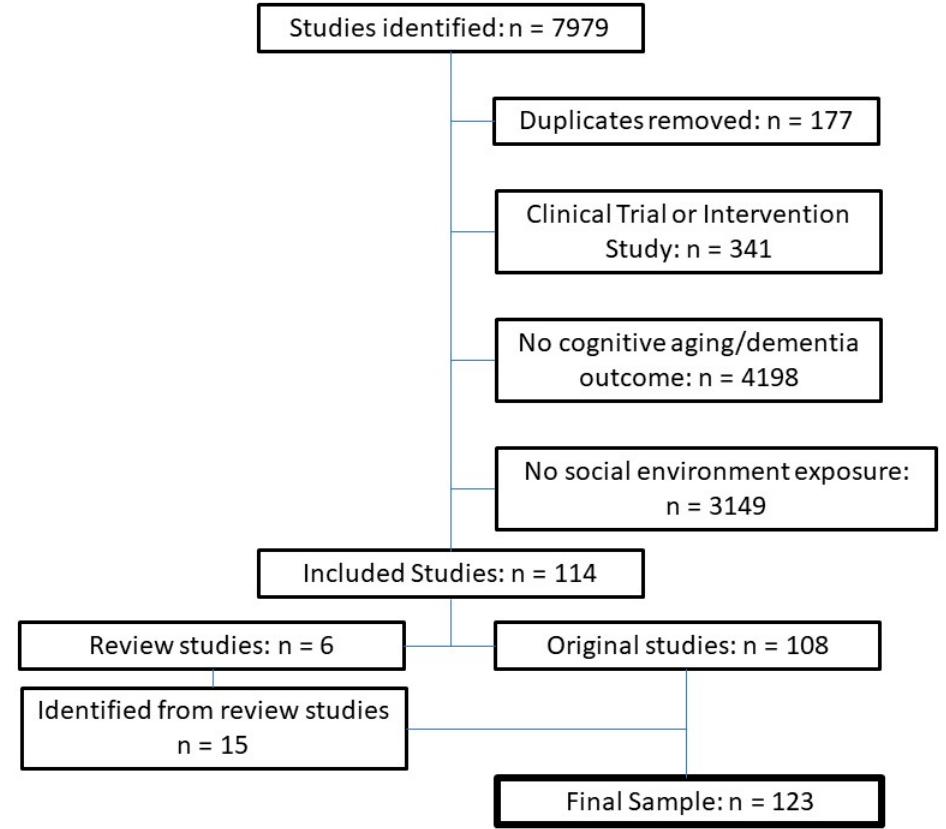
Figure 2. CONSORT flow diagram of study exclusion and inclusion.